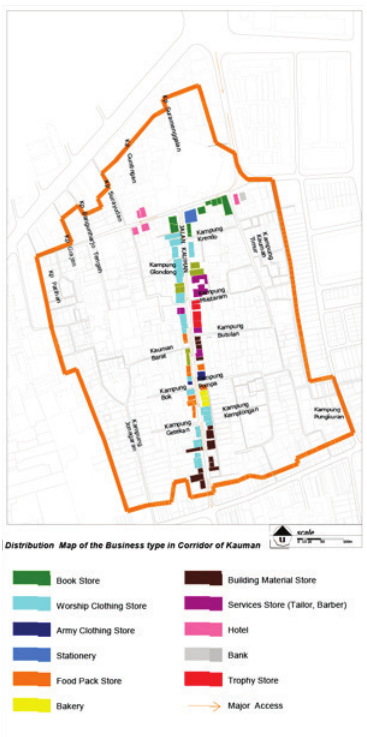
Figure 1. The spread of trading activity in the main corridor of Jl. Kauman